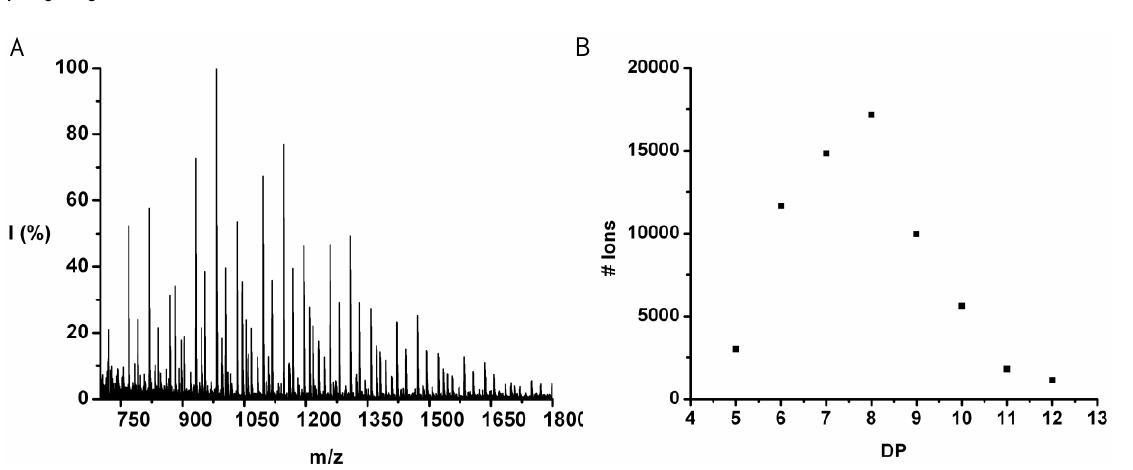
Figure 6. ( A ) MALDI-ToF mass spectrum and ( B ) chain length distribution of poly(Tyr-co-Leu).